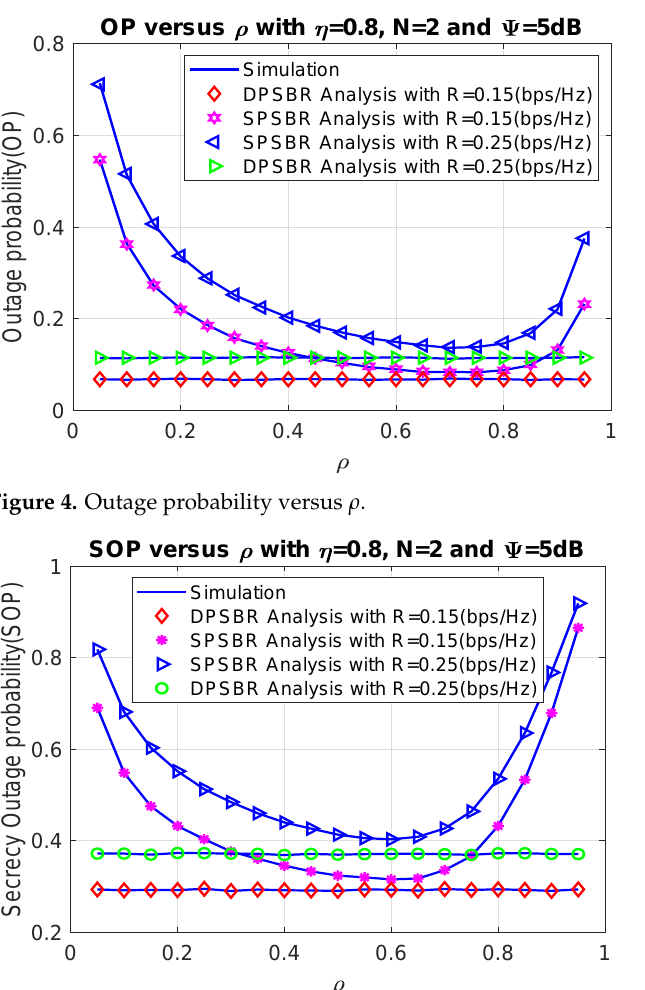
Figure 5. Secrecy outage probability versus ρ